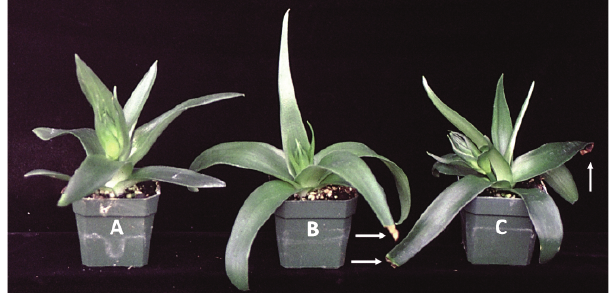
Fig. 3 ­ Leaf spread of Ornithogalum dubium . A) all leaves growing upward (erect) (score 1), B) Old leaves showing prostrate growth (spreading), while young leaves growing upward (score 2), and C) Old leaves drooping and curved inward toward the pot (prostrate) (score 3). Evident leaf tip burn (LTB) symptoms are indicated with